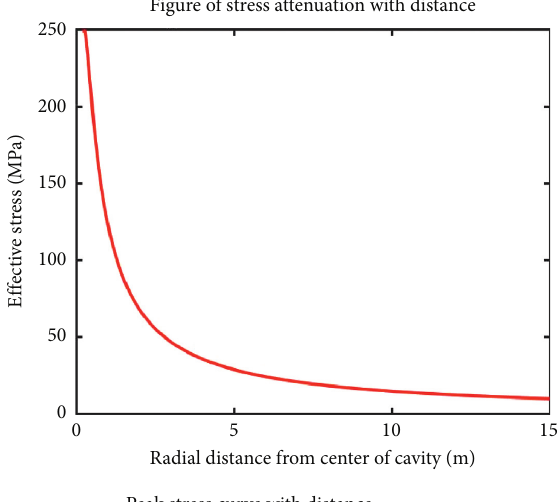
Figure 6: Effective stress attenuation with distance. Figure 4: Principle stress of various direction attenuations with time.